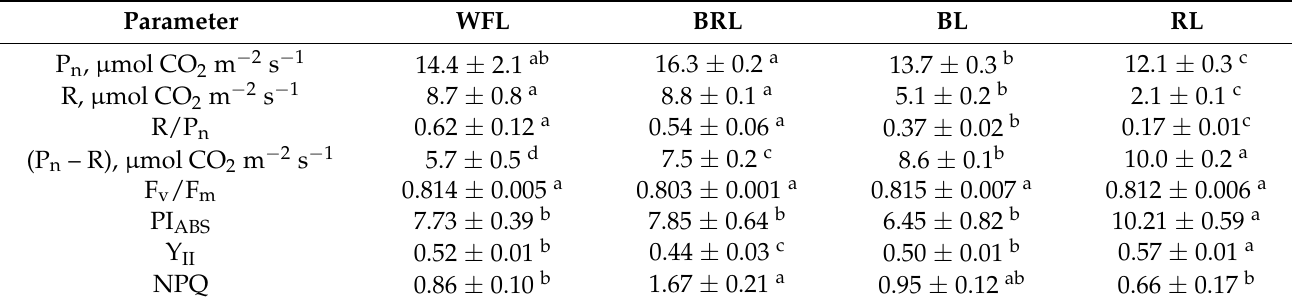
Table 2. Effect of light quality on the net photosynthetic and respiration rates, R/P n ratio, (P n –R) difference, PSII maximum quantum yield (F v /F m ), effective quantum yield Y(II), performance index PSII (PI ABS ), and nonphotochemical fluorescence quenching (NPQ) in 6-week-old P. sylvestris seedlings. Values are the mean ± SE. Different normal-type letters denote statistically significant differences in the means at p < 0.05 (ANOVA followed by Duncan’s method).